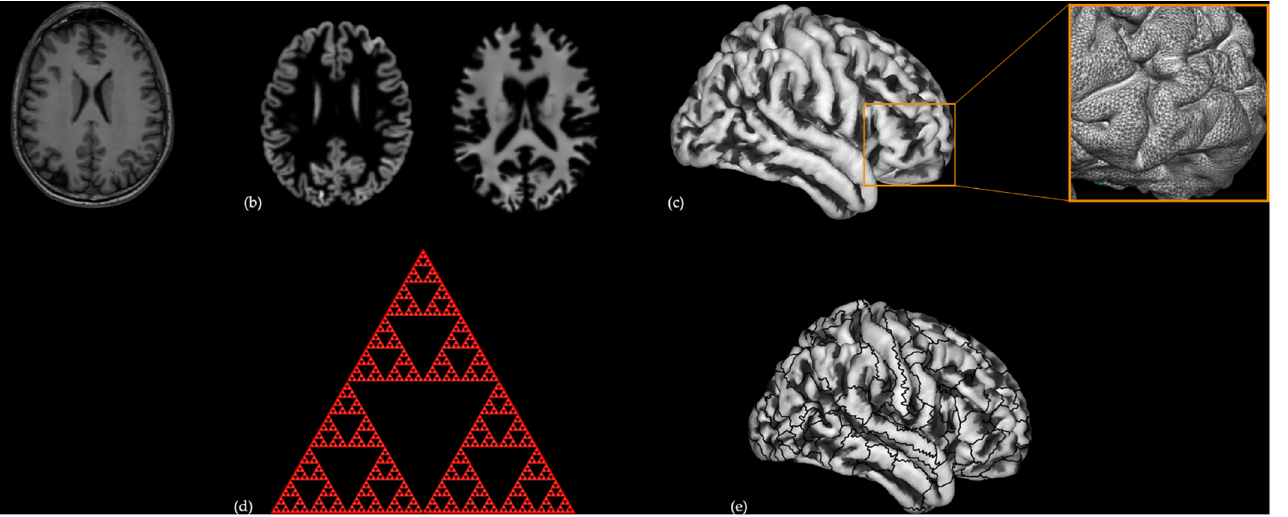
Figure 1. Surface-based cortical measures [fractal dimension (FD) and gyrification index (GI)] estimation process. ( a ) Structural T1 image (in coronal orientation) was registered, normalized, and segmented to extract the; ( b ) grey matter (left) and white matter (right) components. From these maps ( c ) the cortical mesh was reconstructed using the projection-based thickness method (the inset illustrates an example of cortical mesh in the right prefrontal cortex); ( d ) the FD (in the figure, a Sierpi ń ski triangle, which exemplifies the self-similarity concept, i.e., the large equilateral triangle can be decomposed into smaller equilateral triangles at different scales, is depicted) and the GI (not represented) were calculated from the cortical mesh; ( e ) the cortical surface was parcellated in 180 regions of interest (ROI) per hemisphere using the Human Connectome Project multi-modal parcellation atlas and FD and GI values were averaged within each ROI.